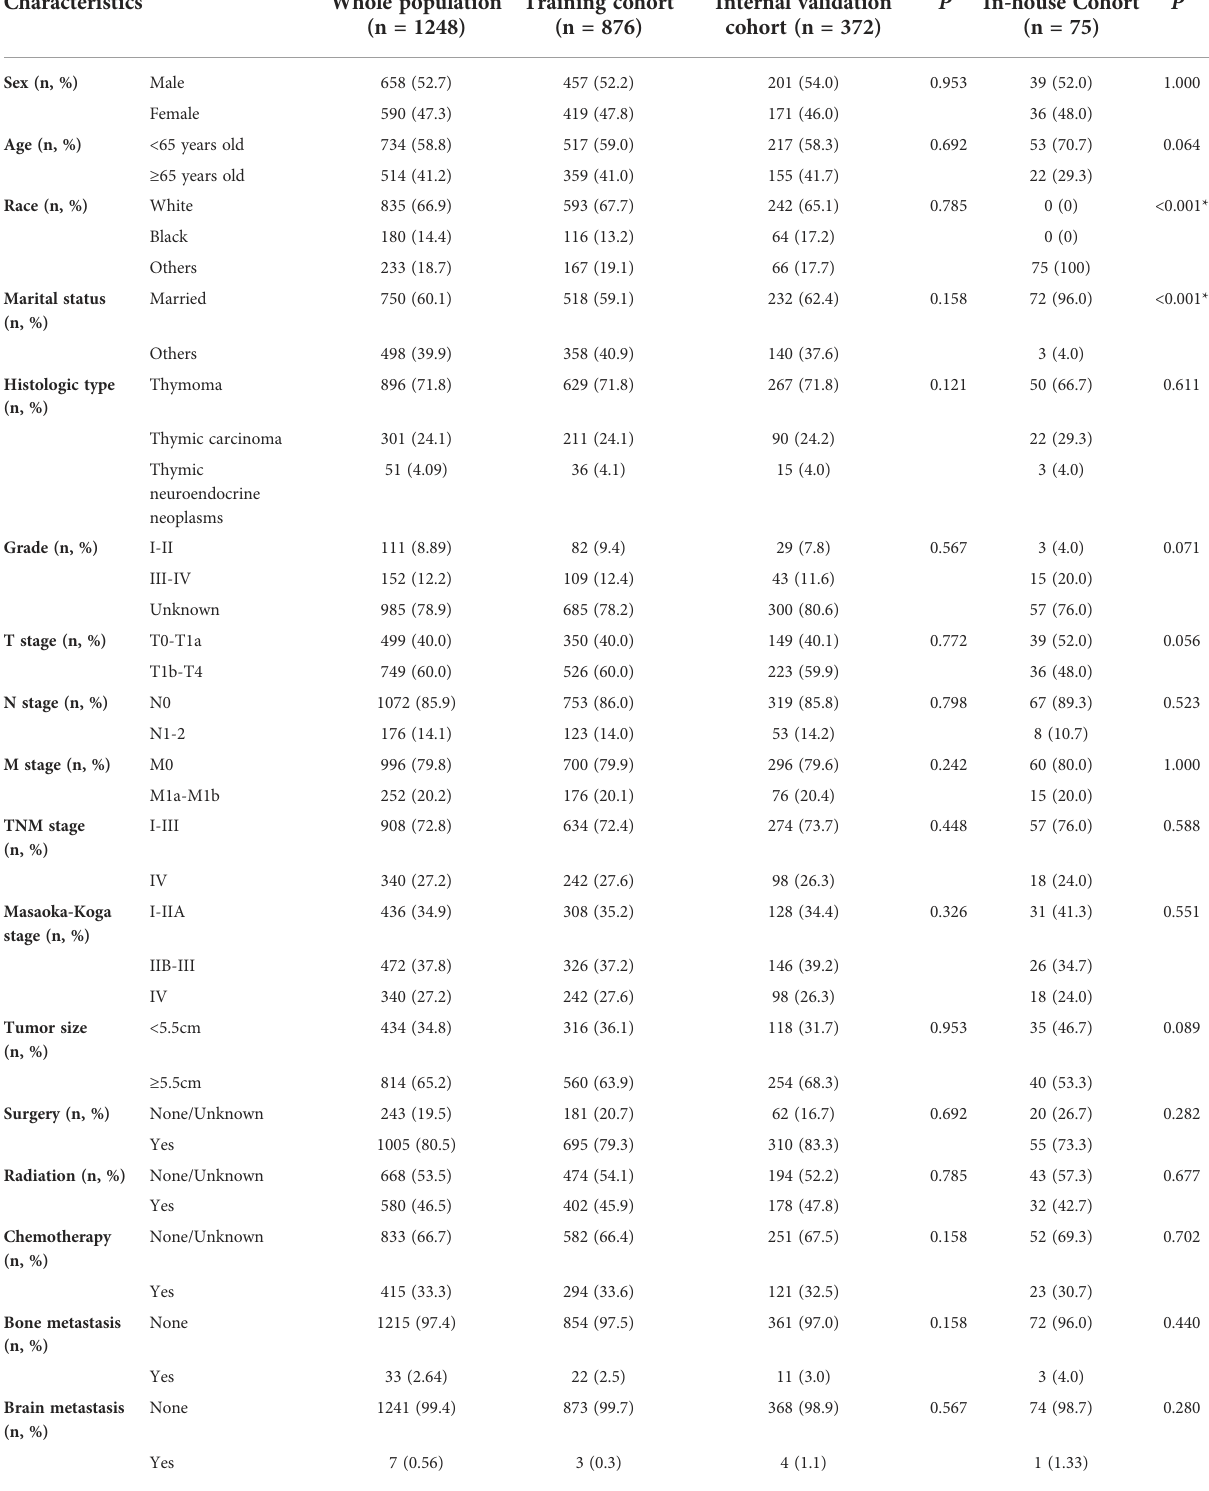
TABLE 1 Demographic and clinical characteristics of patients with TETs.